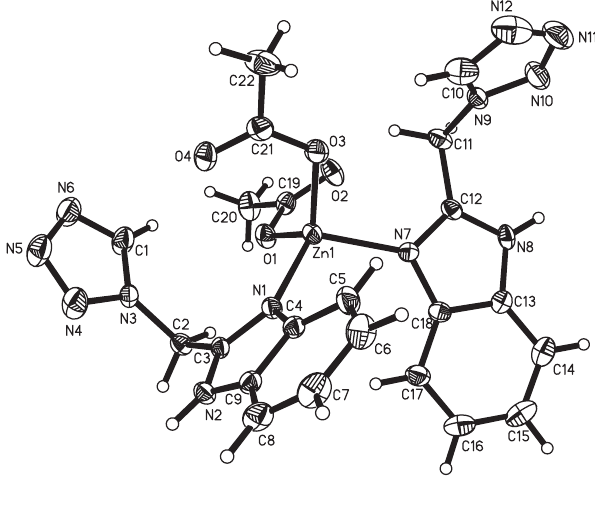
Table 1: Data collection and